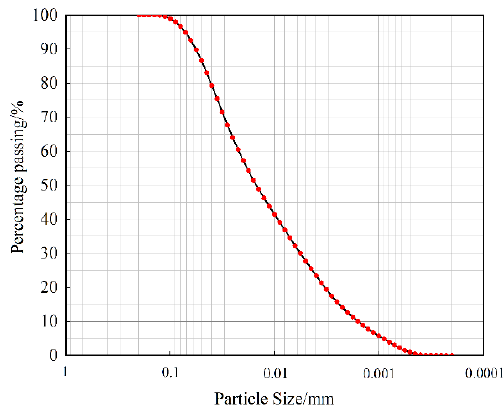
Figure 4. Grain size distribution curve of the clay soil. Table 1. Basic physical properties of the clay